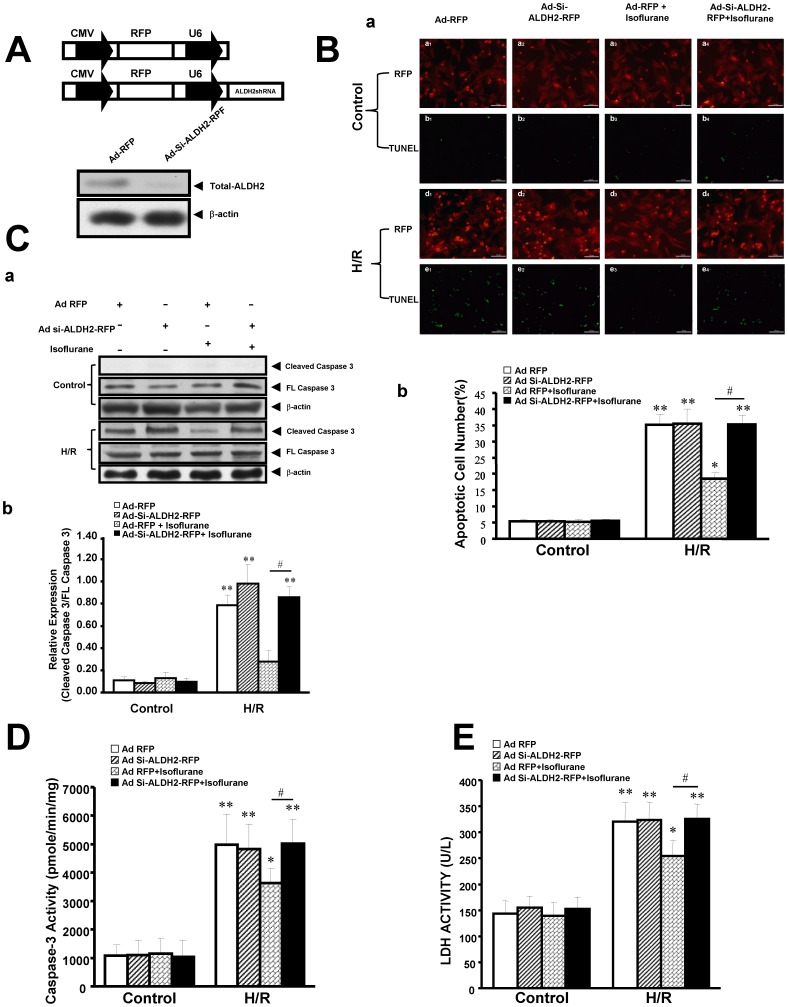
ALDH2 knockdown blocks isoflurane-induced protection against hypoxia/reoxygenation.A. Schematic representation of adenoviruses encoding RFP (Ad-RFP) and ALDH2shRNA (Ad-Si-ALDH2-RFP, left panel); right panel, immunoblotting analysis of ALDH2 protein level. β-actin was used as a control. B. ALDH2 down-regulation inhibited attenuation of TUNEL positive staining level by isoflurane. (a) Apoptotic cells were examined using TUNEL assay for DNA fragmentation. Cardiomyoctes were photographed by fluorescence microscopy after 24 hours of hypoxia followed by 12 hours of reoxygenation. TUNEL-positive nuclei are shown in green and transfection efficiency of adenoviruses in red. (b) Quantitative analysis (percentage of apoptotic cells versus total) is shown in histogram. C. Representative Western blots of cleaved caspase-3 and full length caspase-3 (FL caspase-3) in (a), and 3 independent experiments were quantitated in (b). β-actin was used as a loading control. D. Cell lysates under each condition were quantitatively assayed for caspase-3 activity. E. LDH concentrations in cell culture media were analyzed. Values are means ± S.E.M., n = 5 in each group. *P<0.05, **P<0.01 vs. Control group, and #P<0.05, vs. the corresponding Ad-RFP group.